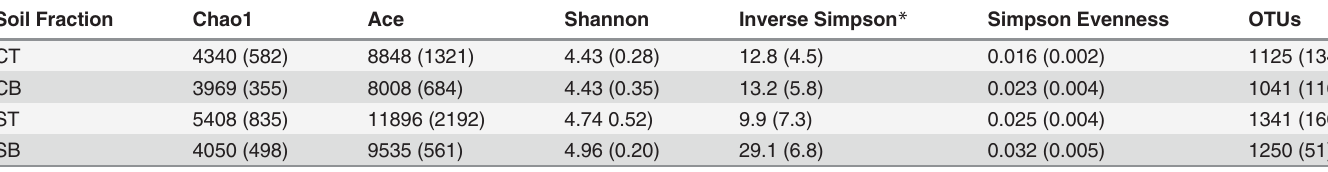
Table 2. Average normalized richness (7,000 sequences per sequence library) and diversity indices for each of the four soil intervals (n = 6 ( ± 1 standard error)). Soil